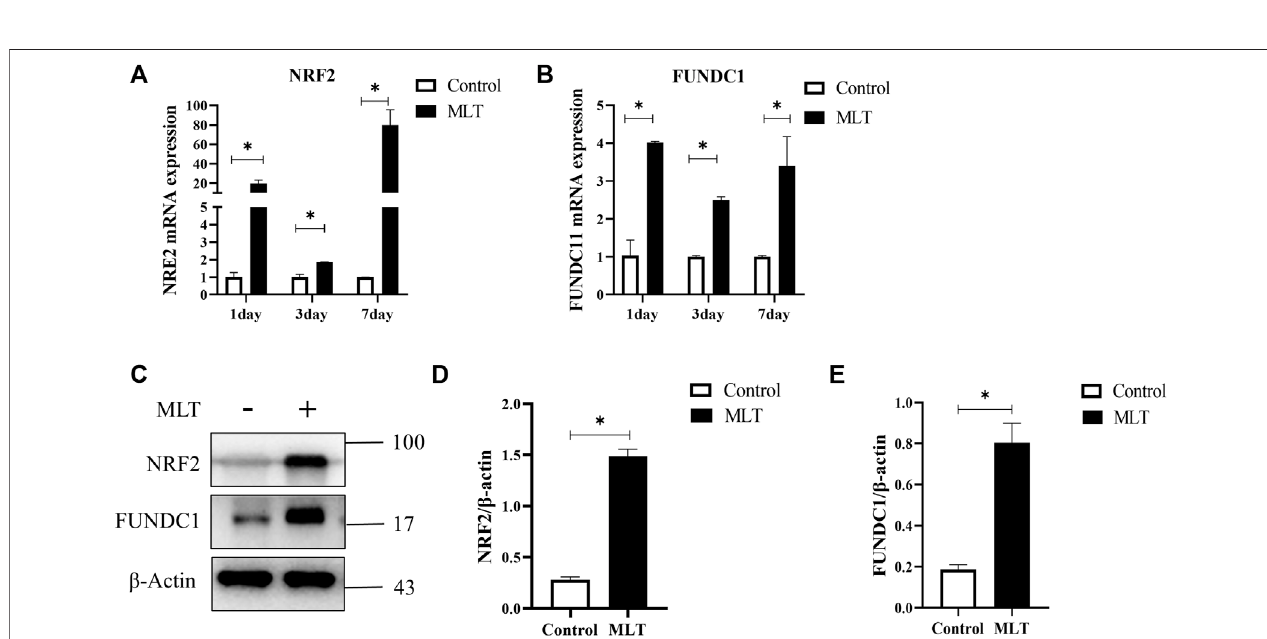
FIGURE 4 | MLT regulated NRF2 and FUNDC1 gene expression. (A) Expression of NRF2 mRNA detected by qPCR. (B) Expression of FUDNC1 mRNA detected by qPCR. (C) Protein levels of NRF2, FUNDC1 and β -actin detected by Western blotting. (D) Quantitative evaluation of NRF2/ β -actin. (E) Quantitative evaluation of FUNDC1/ β -actin; the data are presented as the mean ± SEM, * p < 0.05 versus the control group, n = 3. Abbreviations: MLT, melatonin.